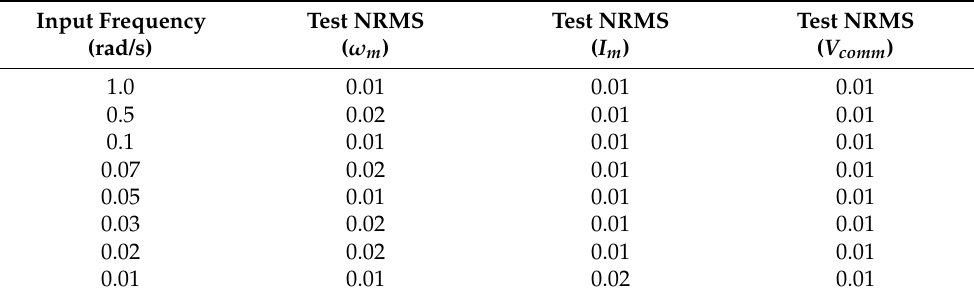
Figure 7. Prediction of RW speed data. Table 6. Model accuracy for different frequencies in the input dataset.